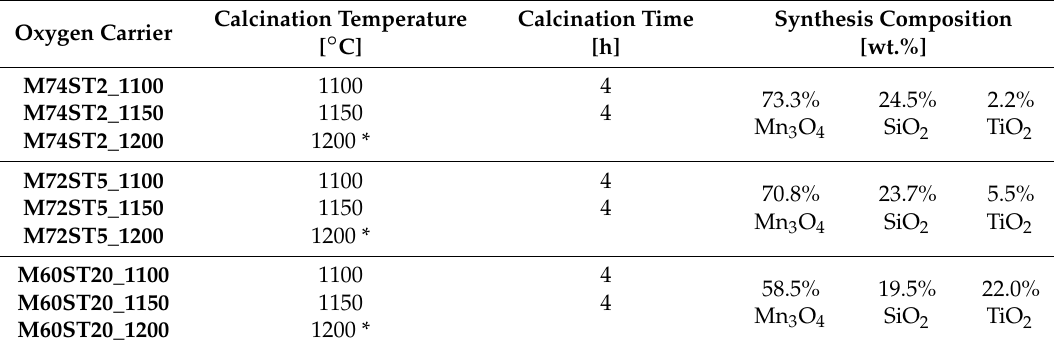
Table 2. Properties of oxygen carriers assessed in this